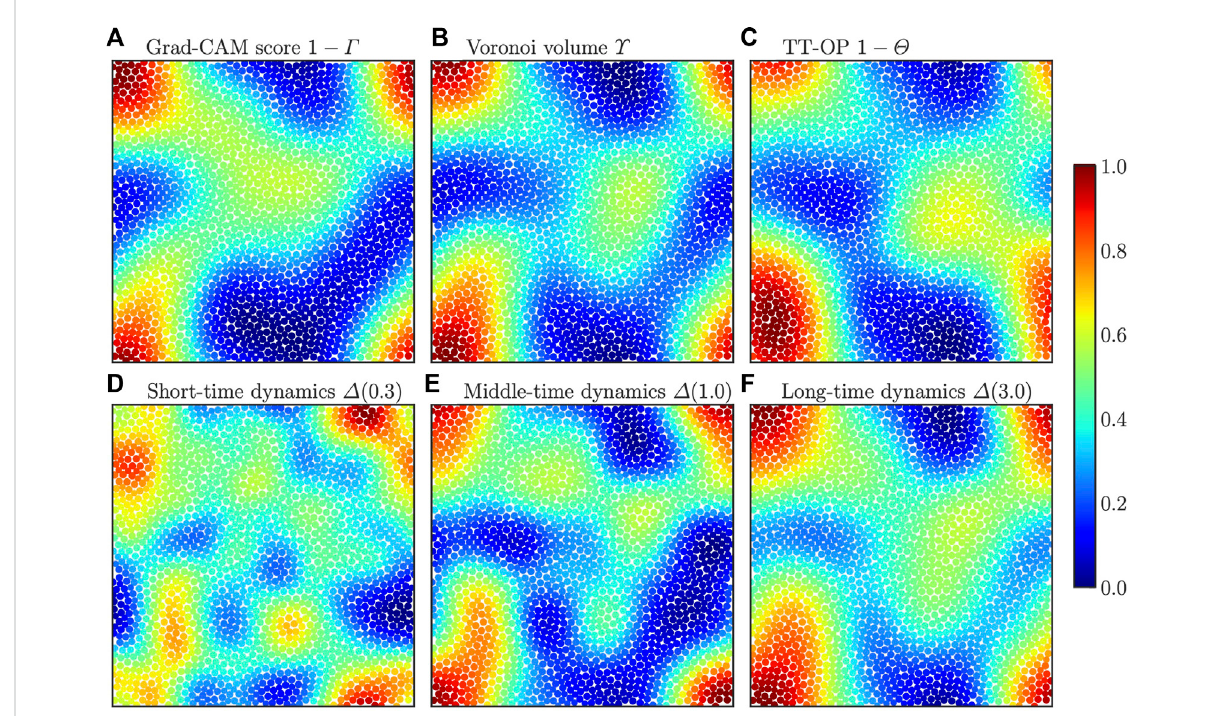
FIGURE 1 Visualization of particle-based structural indicators for a typical glass con fi guration of the Kob – Andersen model (KAM) system: (A) Grad-CAM score ( Γ ), (B) Voronoi volume ( ϒ ), (C) TT-OP ( Θ ), and (D – F) Dynamic propensity ( Δ ) at different “ time ” scales. The argument of Δ stands for the mean intensity ofthedisplacements δ atwhich Δ ismeasured: as indicated inthepanel titles, δ ≈ 0.3,1.0, 3.0,whichroughly correspondsto t ≈ τ α , 3 τ α , 10 τ α , are employed. Notice that all indicators are normalized to [0,1], and the different colors distinguish the values as shown in the color bar. In addition, 1 − Γ and 1 − Θ are shown in panels (A) and (C) , respectively, rather than Γ and Θ , for ease of comparison with the dynamic propensity. The precise values of coarse-graining length ξ X employed here are summarized in Table